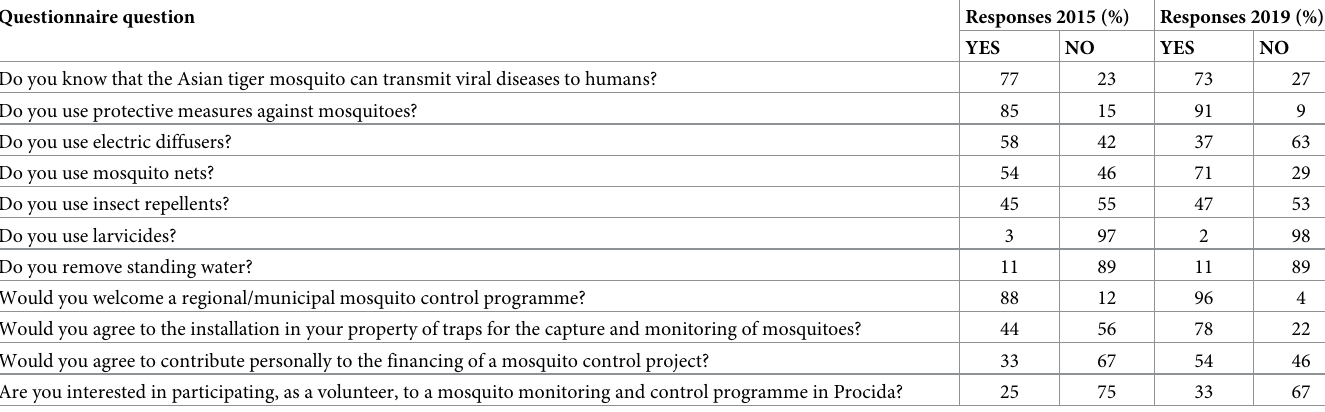
Table 1. Results of public surveys carried out among Procida Island residents in 2015 (N = 200) and 2019 (N = 191) using a questionnaire. Questionnaire